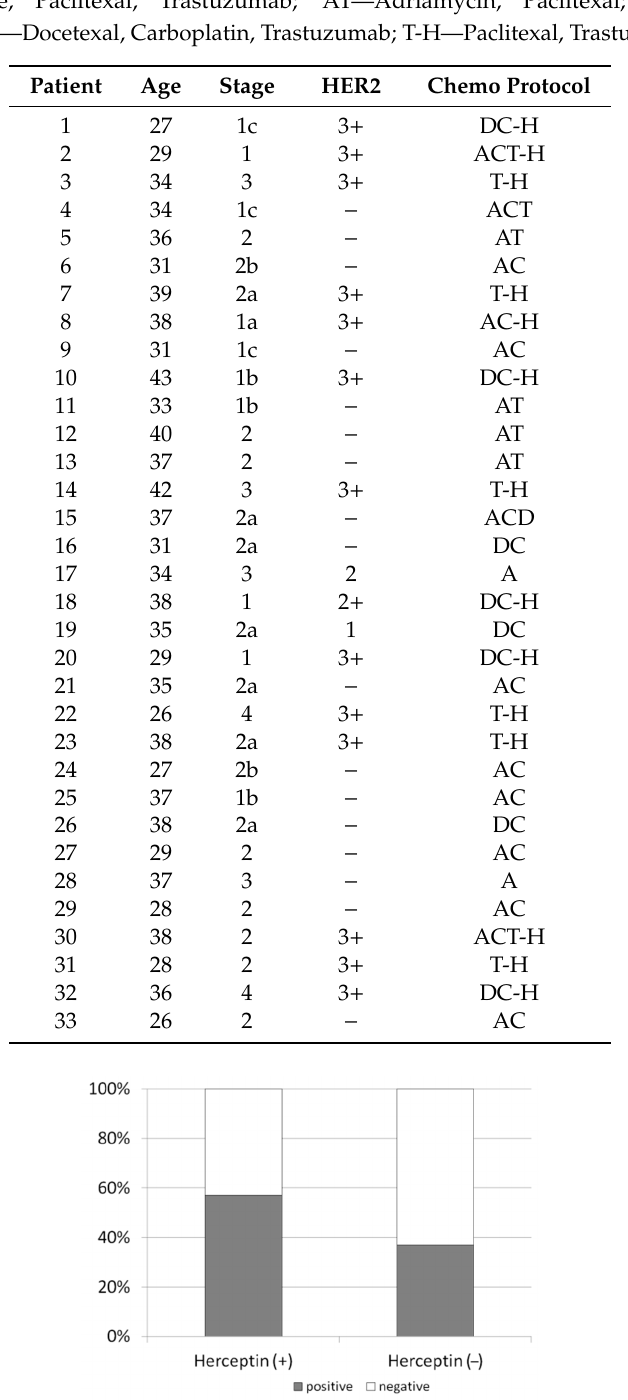
Patients characteristics HER2.